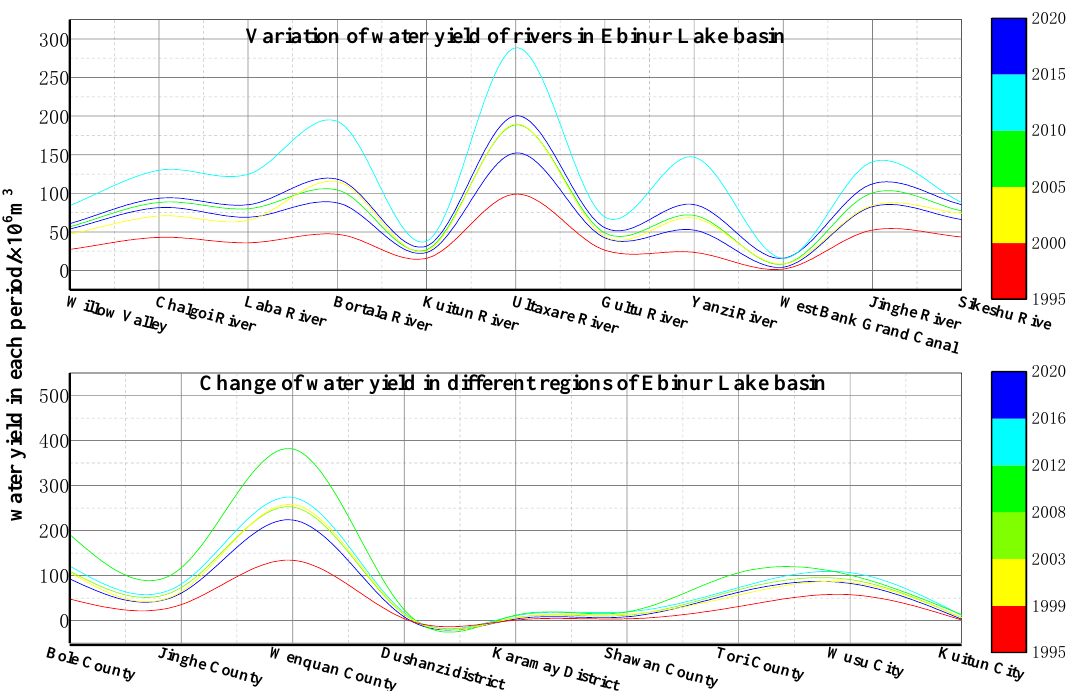
Figure 7. Characteristics of average water yield of each sub-basin and administrative region in the Ebinur Lake Basin.